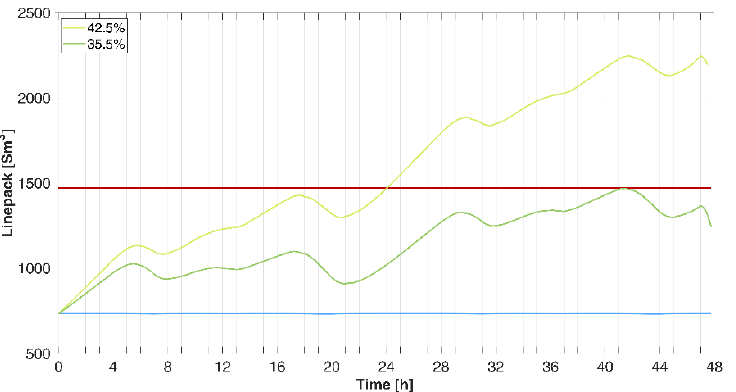
Figure 8. Linepack evolution in case of persistency of the mismatch condition for a whole day (case of a summer weekend). The linepack trend under the reduction case tailored over 24 h only (light green line) is compared to the linepack trend adapted for the 48-h packing (dark green light). The red line represents the maximum acceptable linepack; the light blue line represents the linepack of the 2-bar g case without